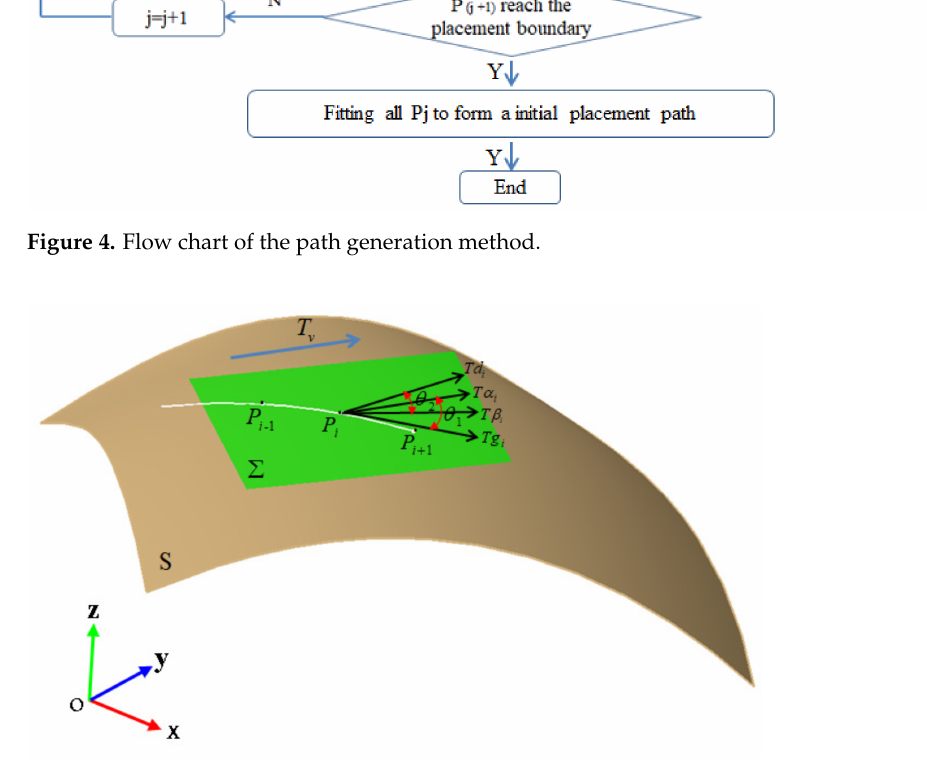
Figure 5. Generation of variable angle